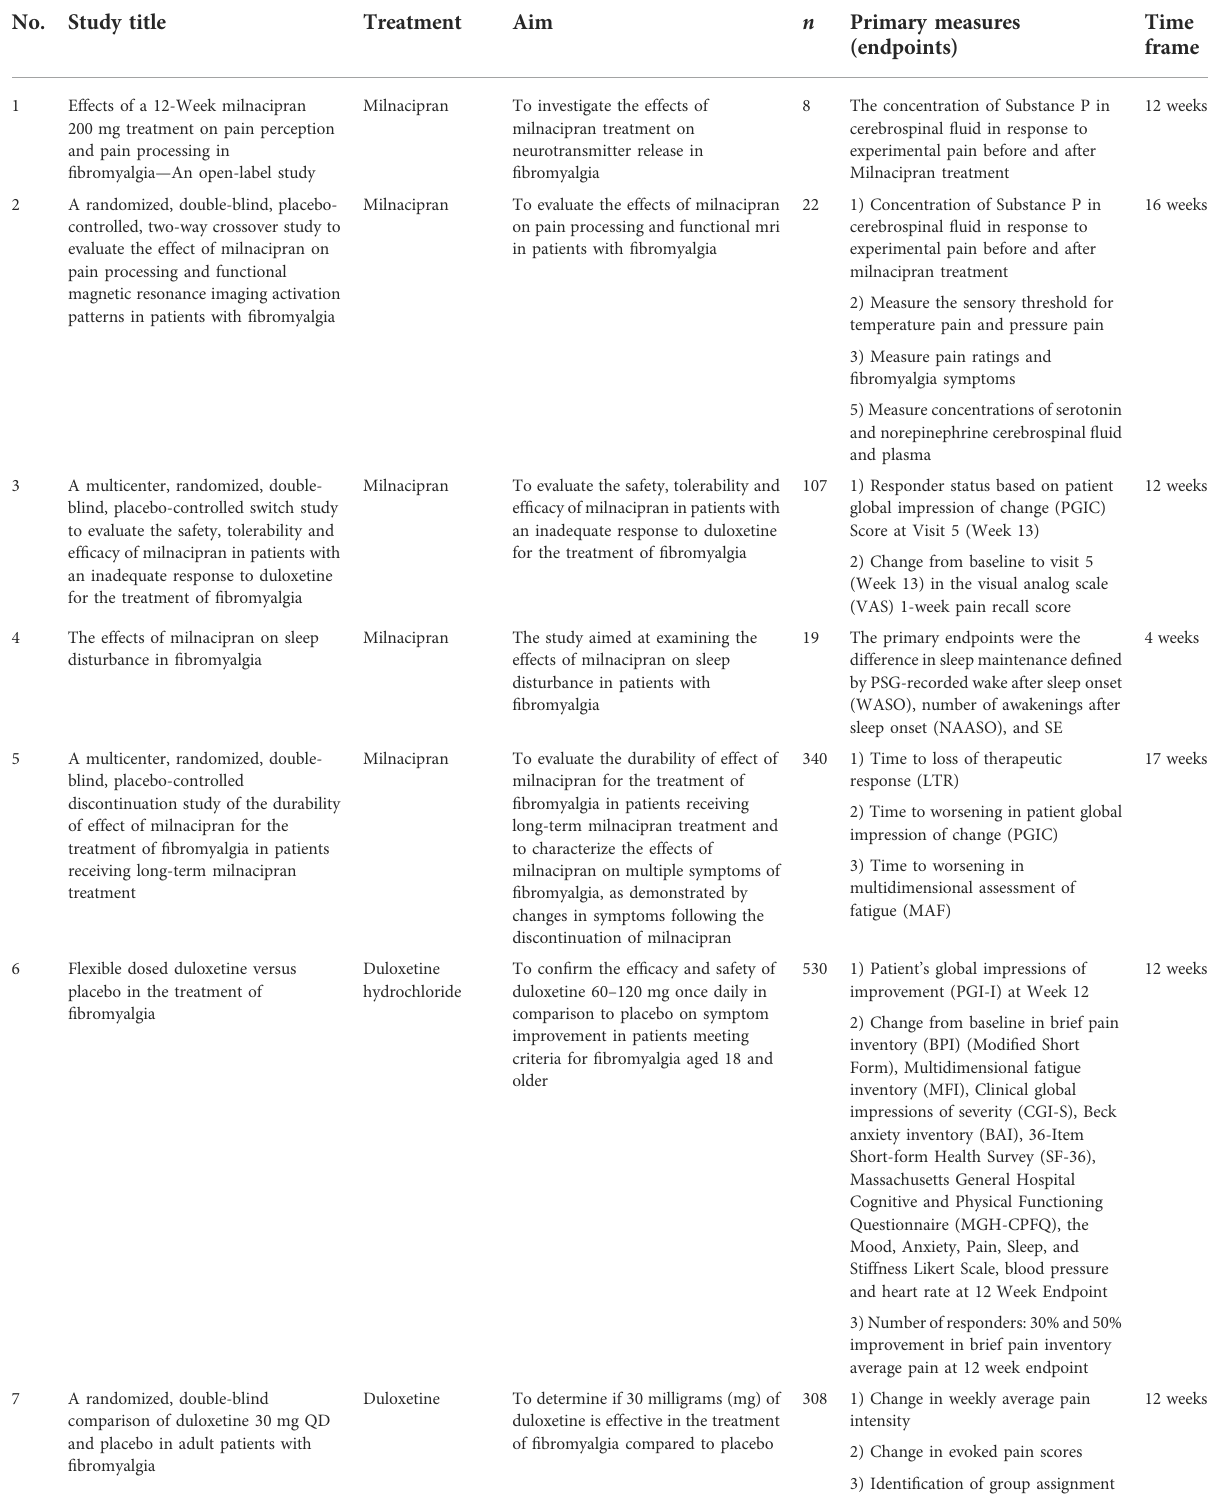
TABLE 1 (Data from https://clinicaltrials.gov, updated on